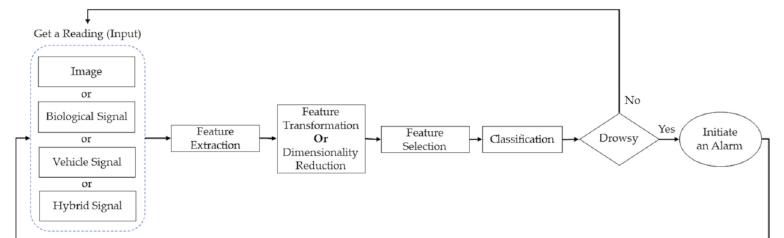
Figure 2. Driver drowsiness detection systems data